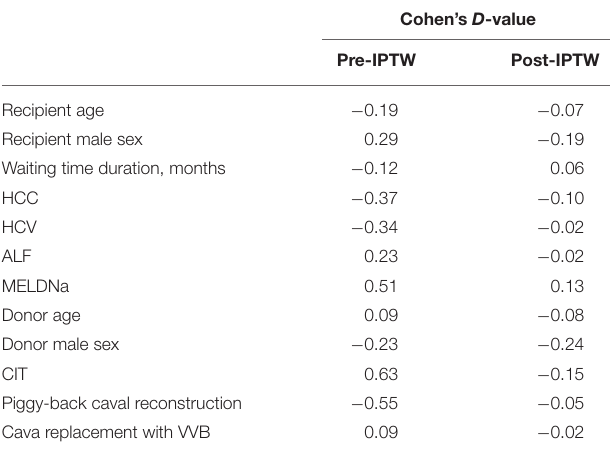
TABLE 3 | Effect of IPTW on the variables used for balancing the two